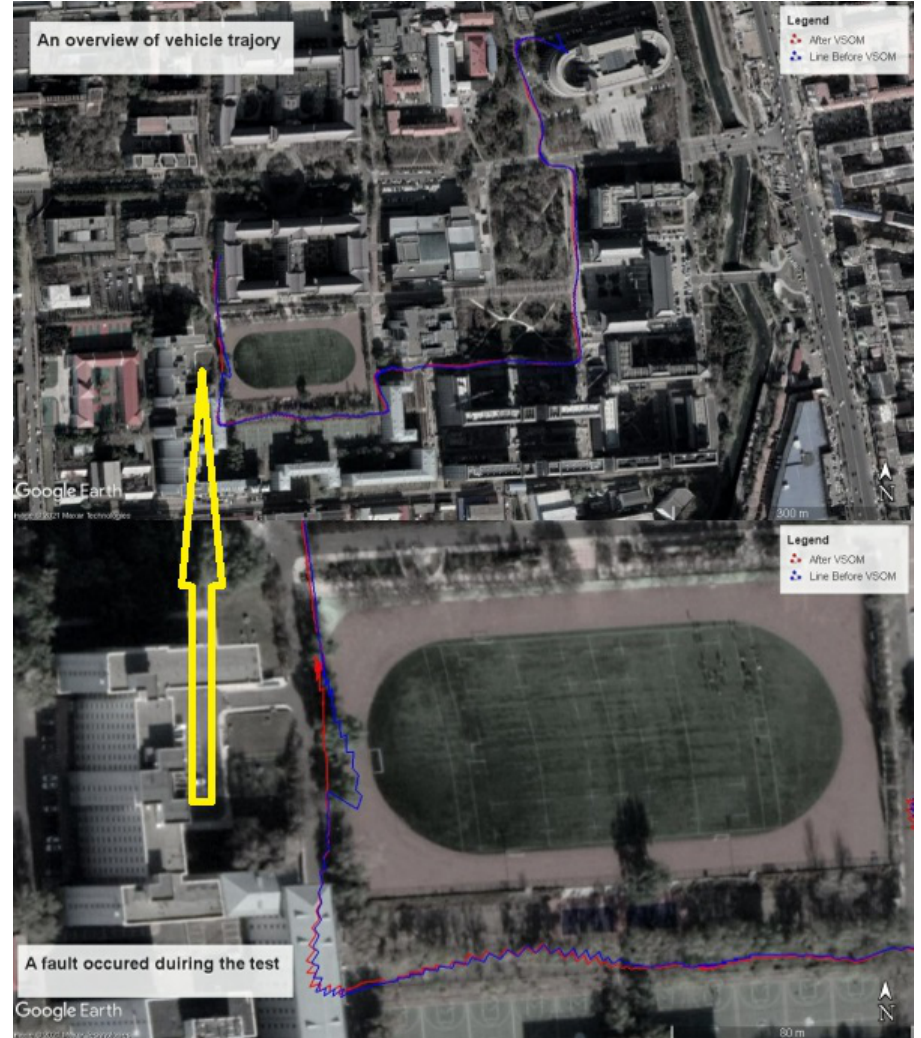
Figure 7. ( up ) An overview of the vehicle’s trajectory. ( down ) A fault occurred during the test. To further reveal the details, the distance from the initial position to the current position over time is shown in Figure 8. As shown in the figure, when the faults occurred, the east/north/upward directions all experienced some disturbance. Before fault detection and identification, the position moved 10 m to the east and 5 m to the south abruptly. A jump in the upward direction of 20 m occurred. After the fault detection and identification, the fault was down-weighted in the estimation process, and the solution was not disturbed. The transitions from the previous position to the fault position, and the fault position to the next position were seamless. This result indicates that the fault detection and identification based on the VSOM could eliminate the vibrations in the estimation caused by the faults. When the weight factors were used for down-weighting approaches to infinity, the corresponding measurements in the estimation were nearly